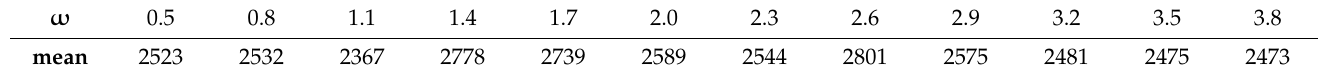
Table 1. The mean values of the meshing forces.